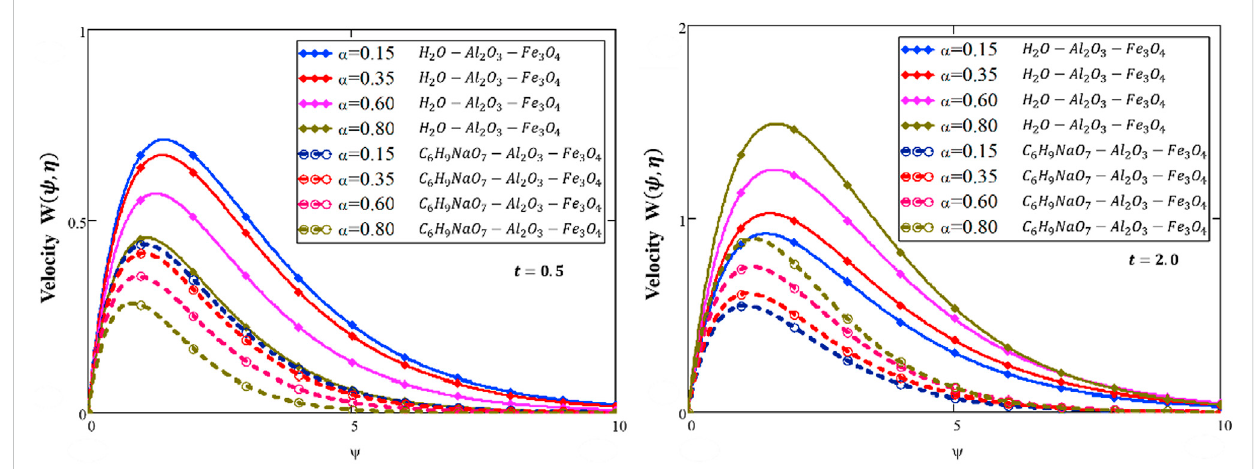
FIGURE 6 Simulation to explain the velocity for fl uctuating α when Pr (cid:3) 3 . 2 , ϕ 1 (cid:3) ϕ 2 (cid:3) 0 . 2 , Gr (cid:3) 8 , Gm (cid:3) 6 . 5 , Sc (cid:3) 0 . 5 , λ 1 (cid:3) 0 . 5 , and λ 1 (cid:3) 0 . 5.